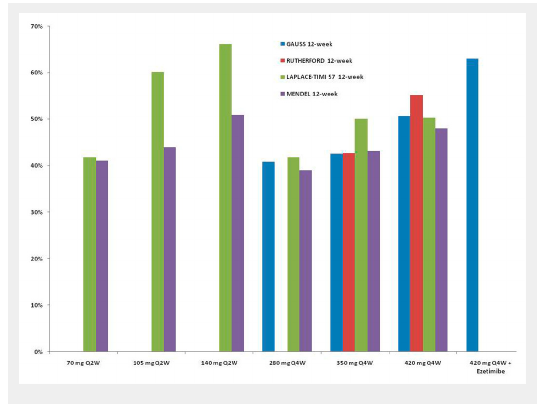
Figure 2 Mean percent decrease from baseline in low-density lipoprotein (LDL) cholesterol levels with the AMG 145 regimen. Results were derived from GAUSS [18], RUTHERFORD [21], LAPLACE-TIMI 57 [19] and MENDEL [20].